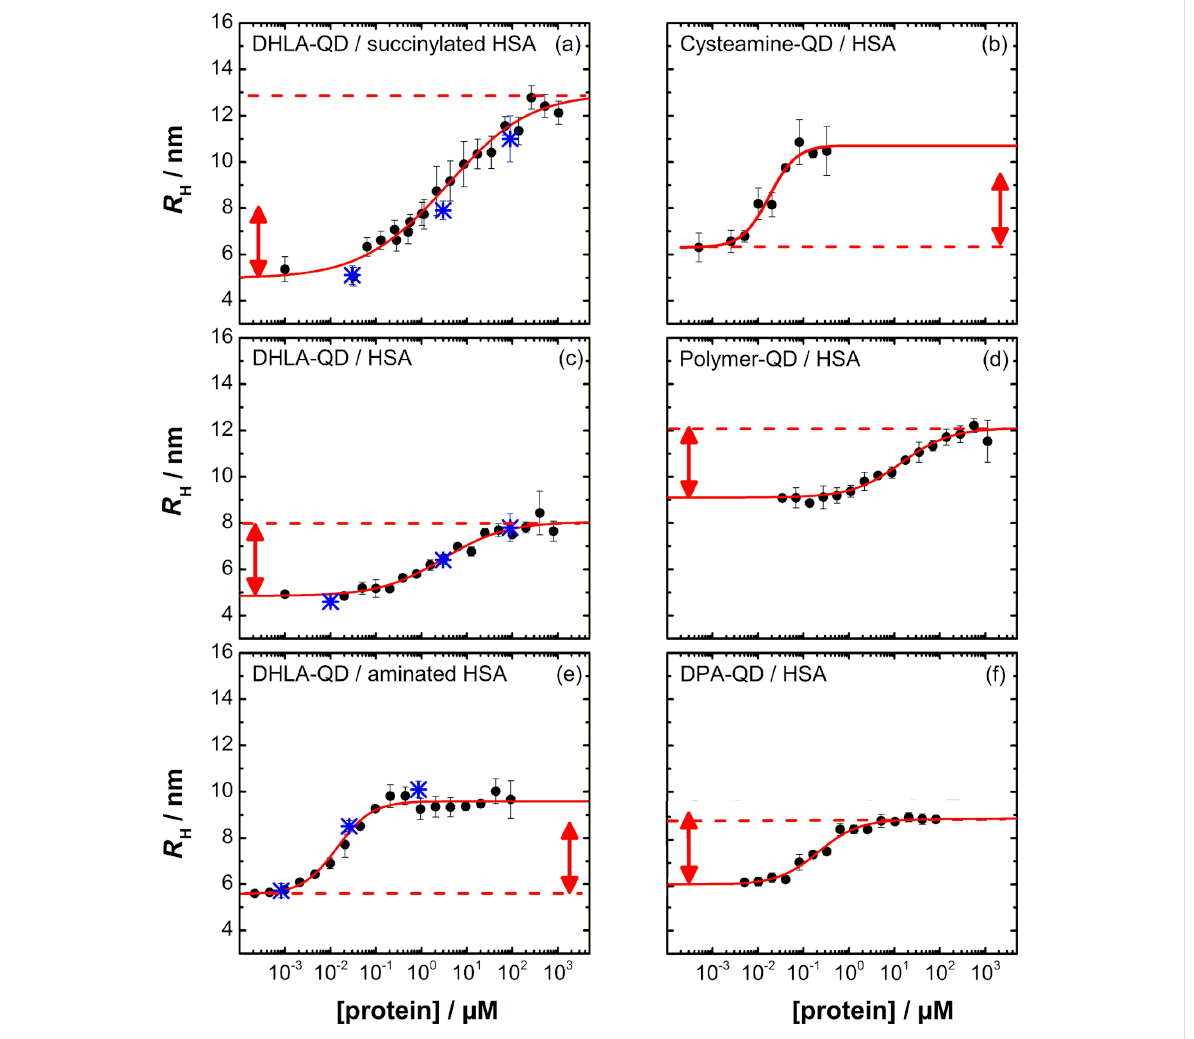
Figure 3: Hydrodynamic radii, R H , of differently functionalized CdSe/ZnS QDs as a function of the concentration of proteins freely diffusing in solution. Details of the NPs and proteins are given in the individual panels. Data (black circles) were fitted with the model given by Equation 1 and Equation 2 (lines); best-fit parameters are compiled in Table 2. Data in a), c), and e) taken from [22] are included for comparison; blue stars represent R H values from controlled desorption experiments. Red arrows with a length corresponding to 3.2 nm are included in each panel to visualize deviations from this